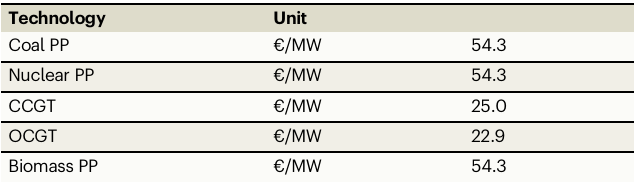
Table 2 | Ramping costs for key power generation technologies Technology